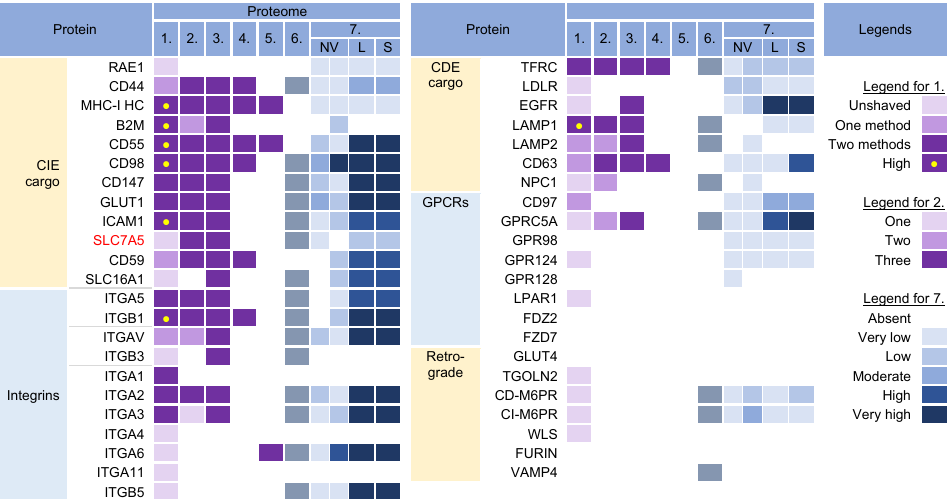
Figure 3. Identification of cargo proteins that travel the endosomal pathways in virion and extracel ‐ lular nanoparticle preparations. Clathrin ‐ independent endocytosis (CIE) [43–46] and clathrin ‐ de ‐ pendent endocytosis (CDE) [47–52] cargo proteins, integrins (both CIE and CDE proteins) [53], G protein ‐ coupled receptors (GPCRs) [54], and cargo proteins of the retrograde EE ‐ to ‐ TGN pathway [48,55] were identified in five proteomes of HCMV virion preparations and one proteome of HSV ‐ 1 heavy particles as described in Figure 2. Proteome 7 [16] shows the abundance of a cargo protein in high ‐ resolution density ‐ gradient ‐ purified non ‐ vesicular (NV) samples of DKO ‐ 1 cells (left box) and Gli36 cells (right box), lEV (L), and sEV (S) samples of DKO ‐ 1 cells. A color code of very low (less than 2 × log 2 abundance relative to average signal) was set up as a threshold [16]. Low means